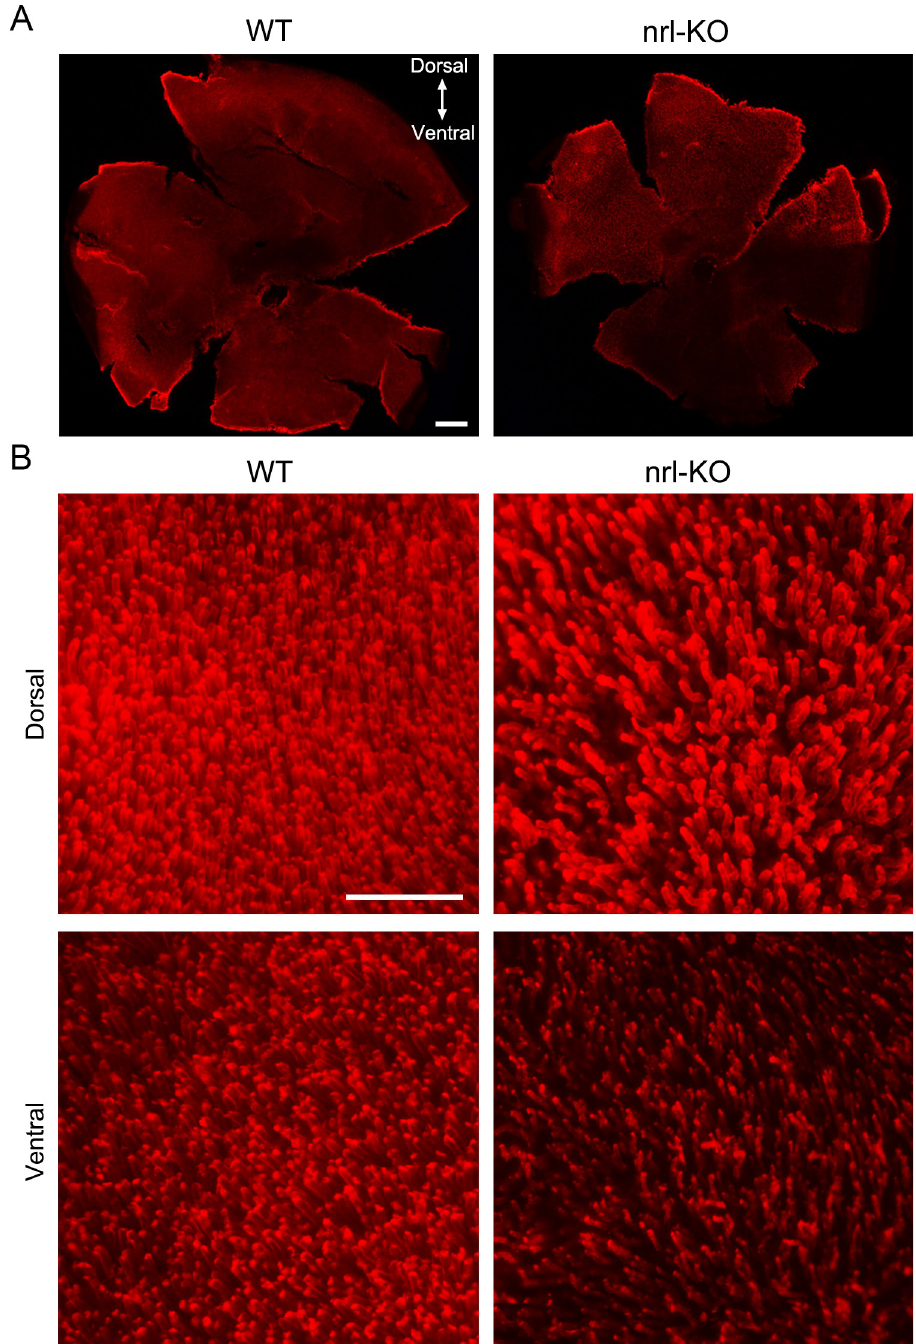
Fig 2. Reduced density of the rod outer segments in the nrl -KO zebrafish. (A) The rod outer segments were visualized via immunostaining on the flattened whole-mount retinas from WT and nrl -KO zebrafish at 2 mpf using the anti-Rho antibody. The overall views of WT and nrl -KO retinas are shown in the low-magnification images. Scale bar: 200 μ m. (B) High-magnification images from the dorsal and ventral retinal regions are shown. The density of rods is reduced in the nrl knockout retinas, especially in the ventral retinal region. Scale bar: 50 μ m.